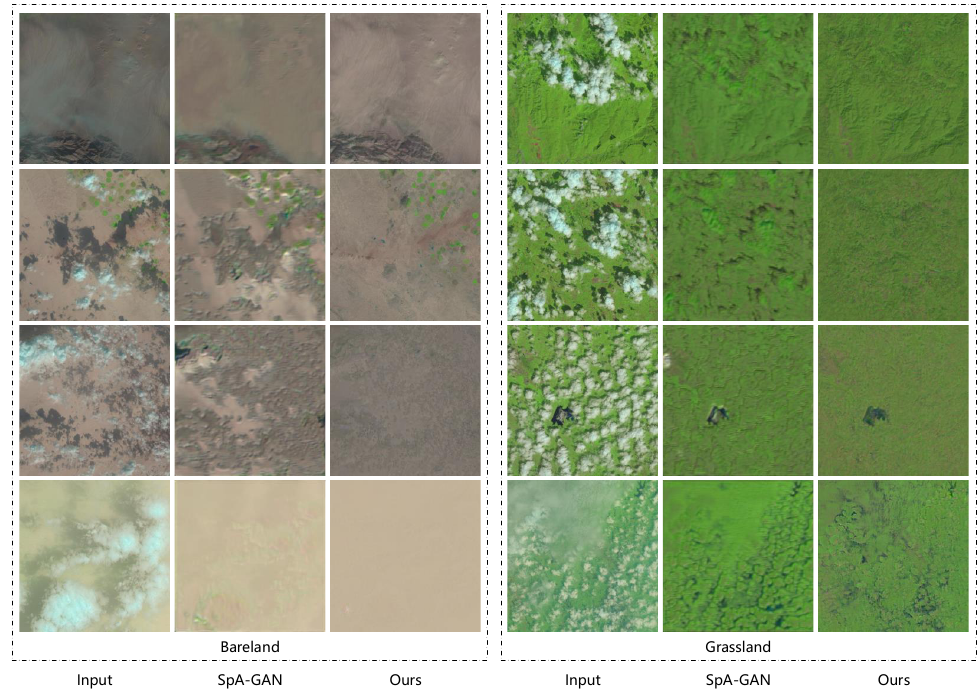
Figure 7. Our cloud removal results compared with SpA-GAN on the RICE2